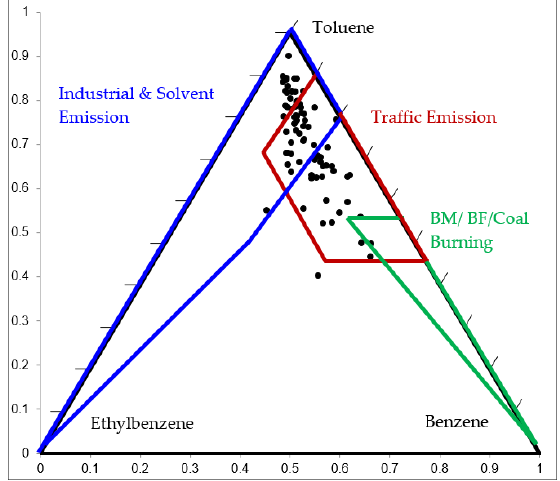
Figure 3. Concentration ( a ) and contribution ( b ) of five VOCs categories within the industrial areas.